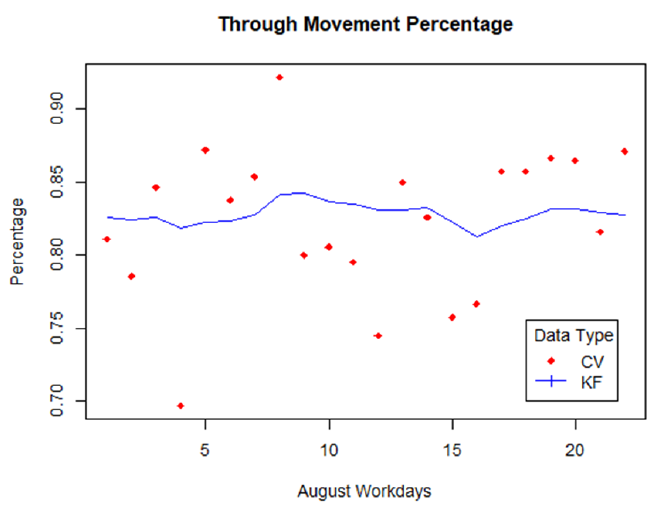
Figure 7. Northbound Through Movement 4:15 to 6:15 p.m. August, 2021.